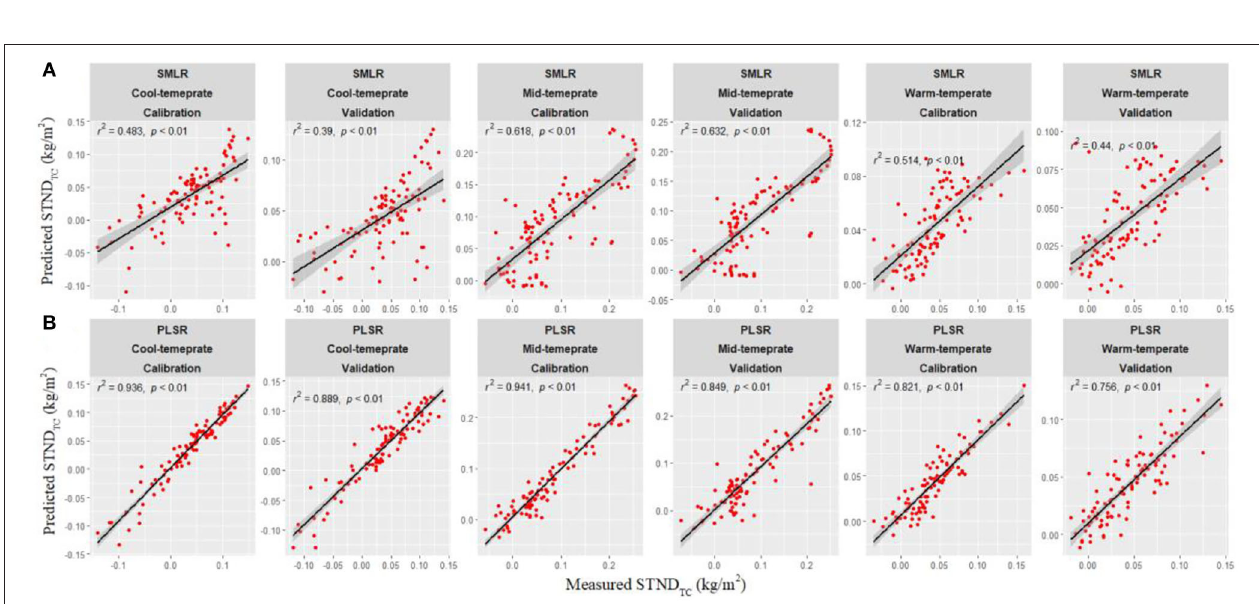
FIGURE 5 | Root mean square error (RMSE) and coefficient of determination (R 2 ) at a different number of latent variables (NLV) in the calibration and validation procedures for (A) cool-temperate, (B) mid-temperate, and (C) warm-temperate transects. The black frames stand for the optimum number of a latent variable (ONLV) determined by the leave-one-out cross-validation in the calibration procedure.